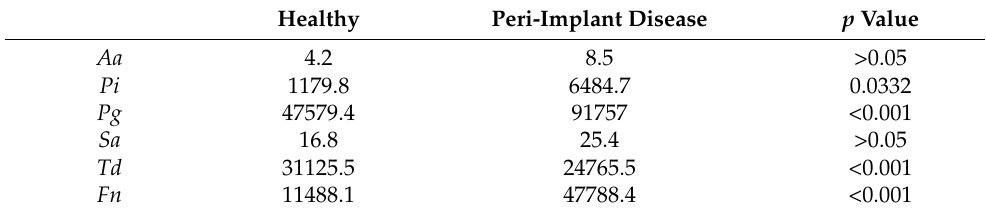
Table 2. Total bacterial counts dividing patients in groups by peri-implant status (healthy vs. peri- implant